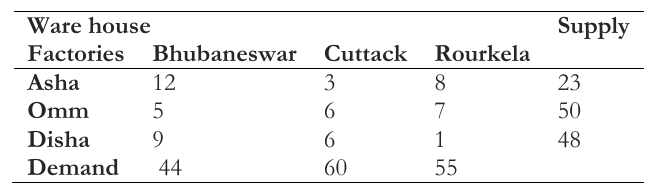
Table 4. Balanced transportation problem.